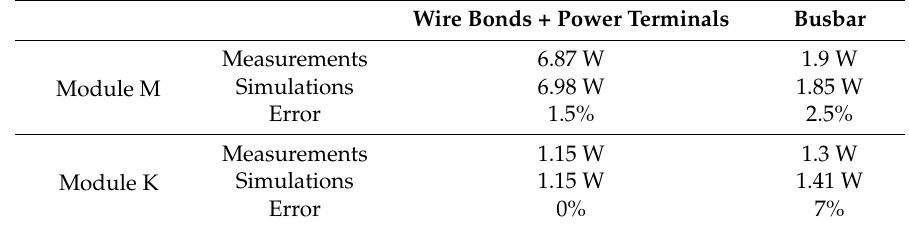
Table 4. Power dissipation P J in the different elements— I eff = 150 A. The error is defined by: (maximum value—minimum value)/(minimum